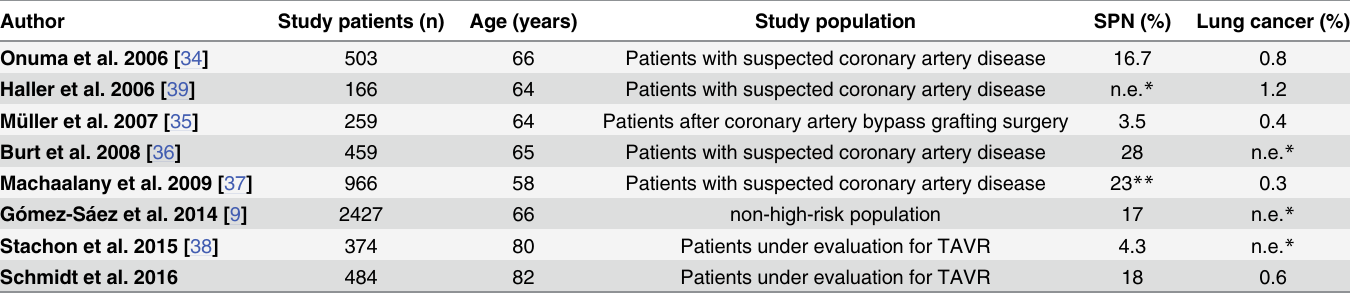
Table 1. The incidence of incidentally discovered SPN (cases on chest computer tomographies) and the number of diagnosed lung cancer